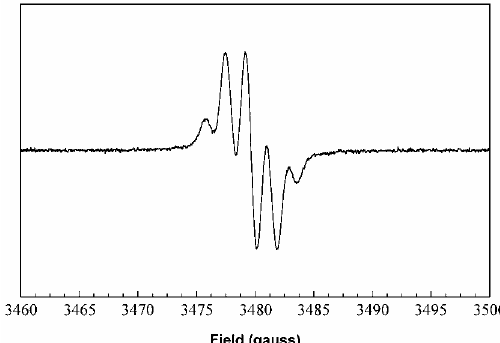
Figure 5. Room temperature ESR spectrum derived from oxidation of 16 in toluene at